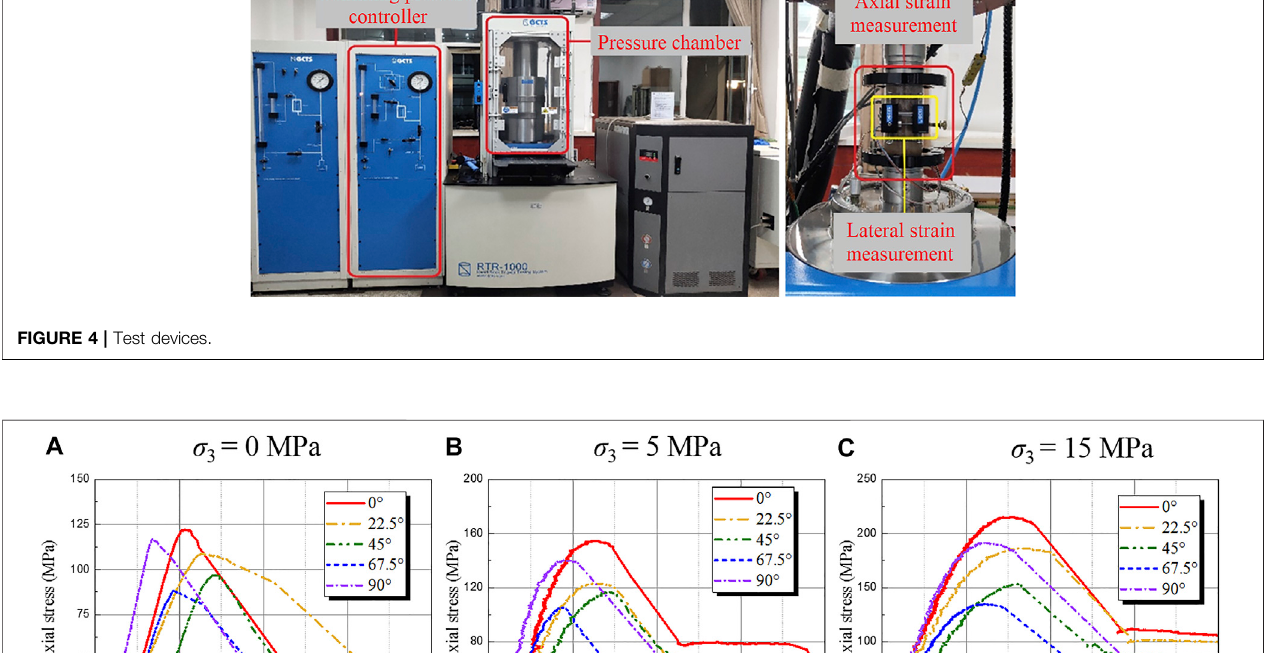
Frontiers in Earth Science |